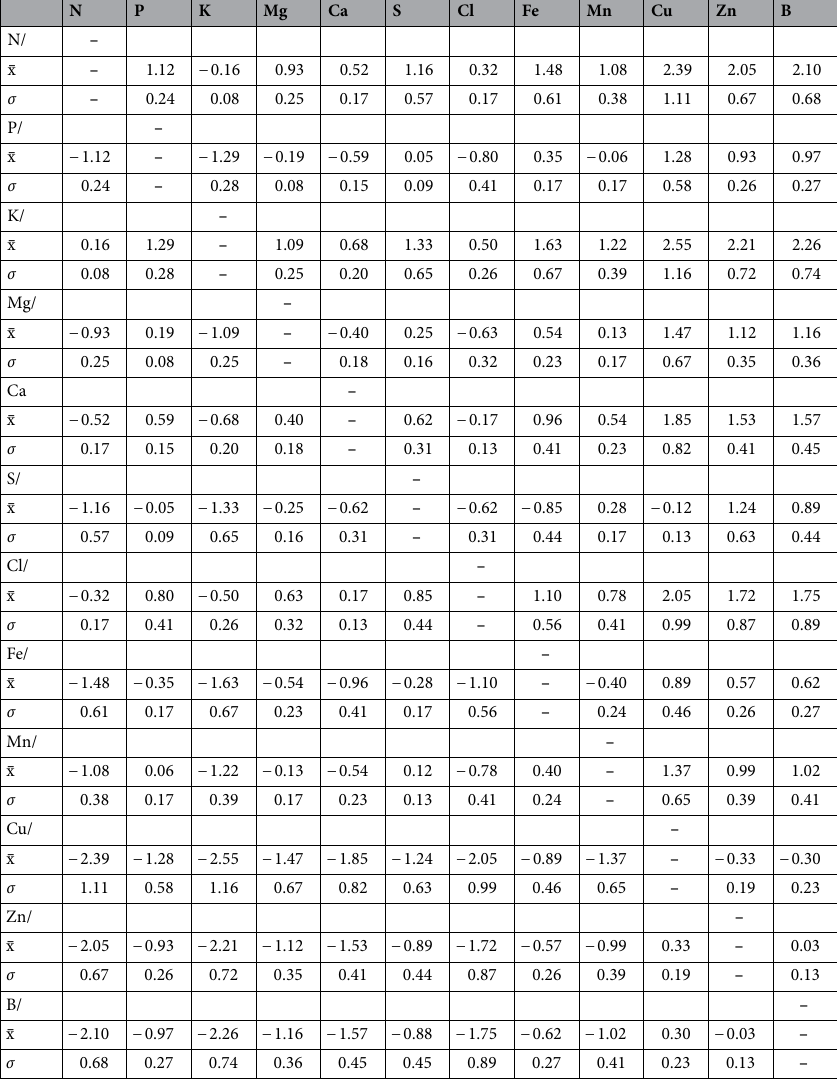
Table 2. Mean (x ̄ ) and standard deviation (σ) of the resulting bivariate nutritional association of leaf dry matter samples obtained from the high productivity subpopulation of banana ( Mussa spp.) for the establishment of DRIS